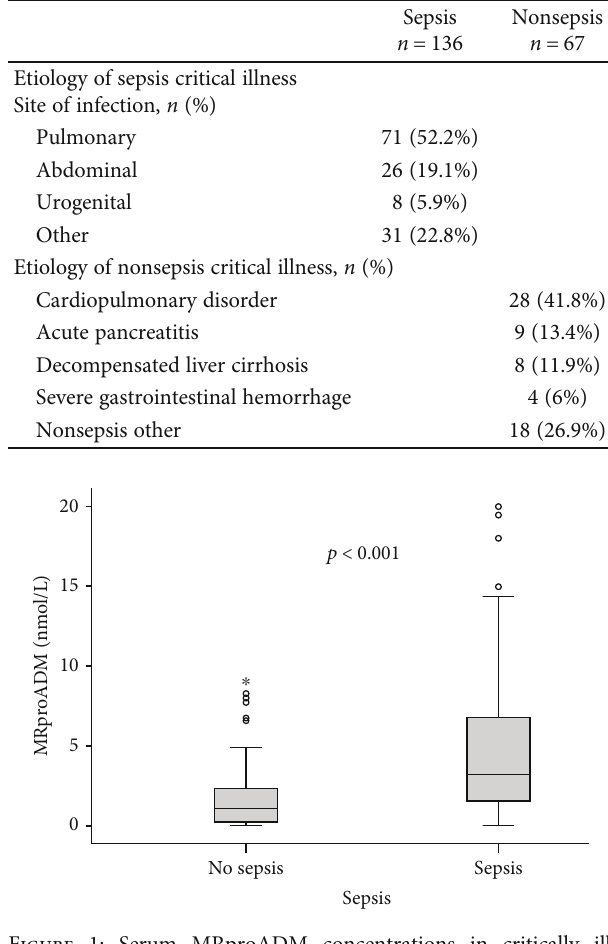
Figure 1: Serum MRproADM concentrations in critically ill patients and sepsis. MRproADM levels were signi fi cantly higher in patients with sepsis compared to ICU patients without sepsis (median 3.2 vs 1.1nmol/L; p < 0 : 001